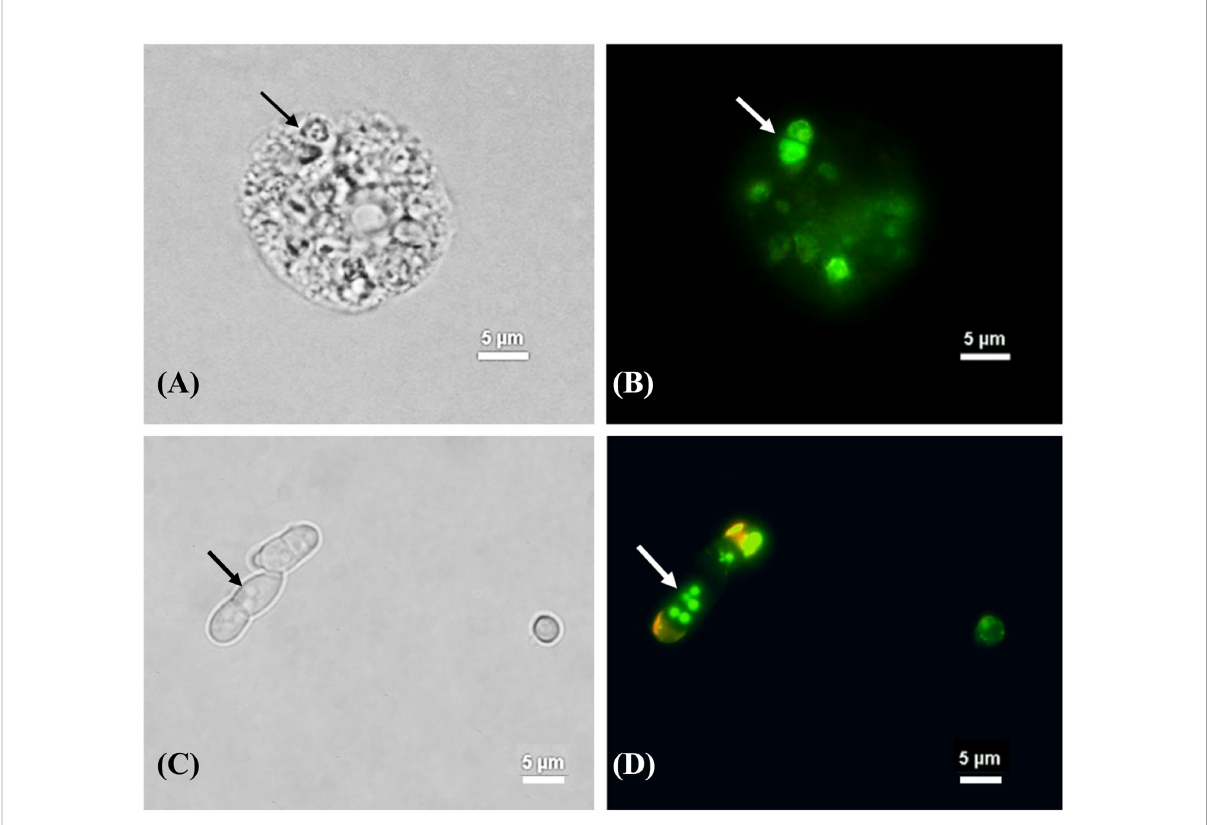
FIGURE 5 The melanization of T. marneffei interacting with A . castellanii after co-cultivation at 37°C. The corresponding bright fi eld (A, C) and immuno fl uorescence (B, D) , the images showing the green signal of T. marneffei yeast cells immunostaining with anti- fungal melanin antibody (MAb 8D6) and Alexa fl uor 488 conjugated goat anti-mouse IgM after 48 h co-incubation with A . castellanii . The arrows indicated fi ssion yeast cells (A, B) and the melanin granules of T. Marneffei (C, D) . The picture was taken under 1,000x magni fi cations with a Nikon Eclipse 50i fl uorescence